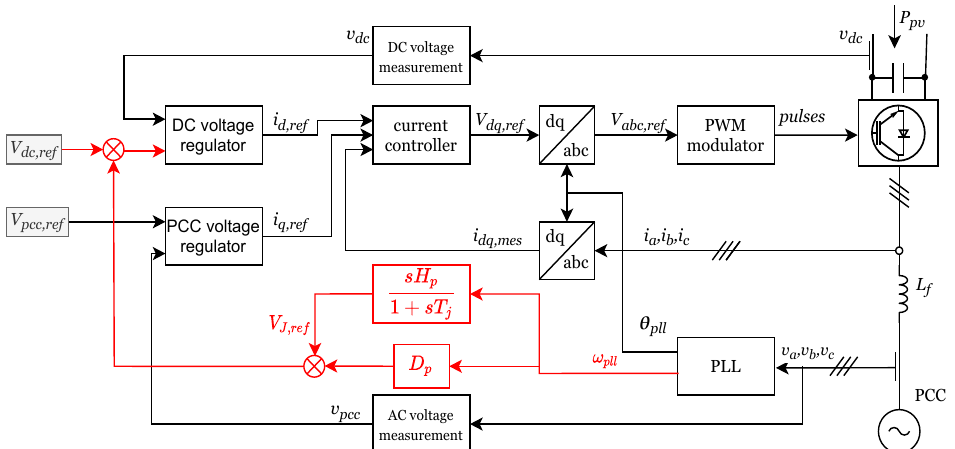
Figure 5. ROCOF VSG (Rate of Change of Frequency Virtual Synchrnous Generator) block